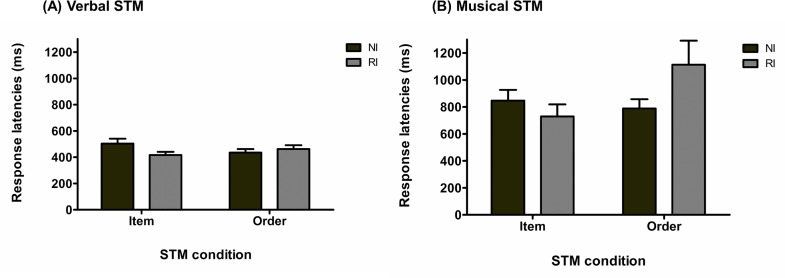
Response latencies for Experiment 2.(A) Response latencies (mean and standard error) for the vSTM task as a function of STM task and interference conditions (NI: no-interference; RI: rhythmic interference). (B) Response latencies (mean and standard error) for the mSTM task as a function of STM and interference conditions (NI: no-interference; RI: rhythmic interference).